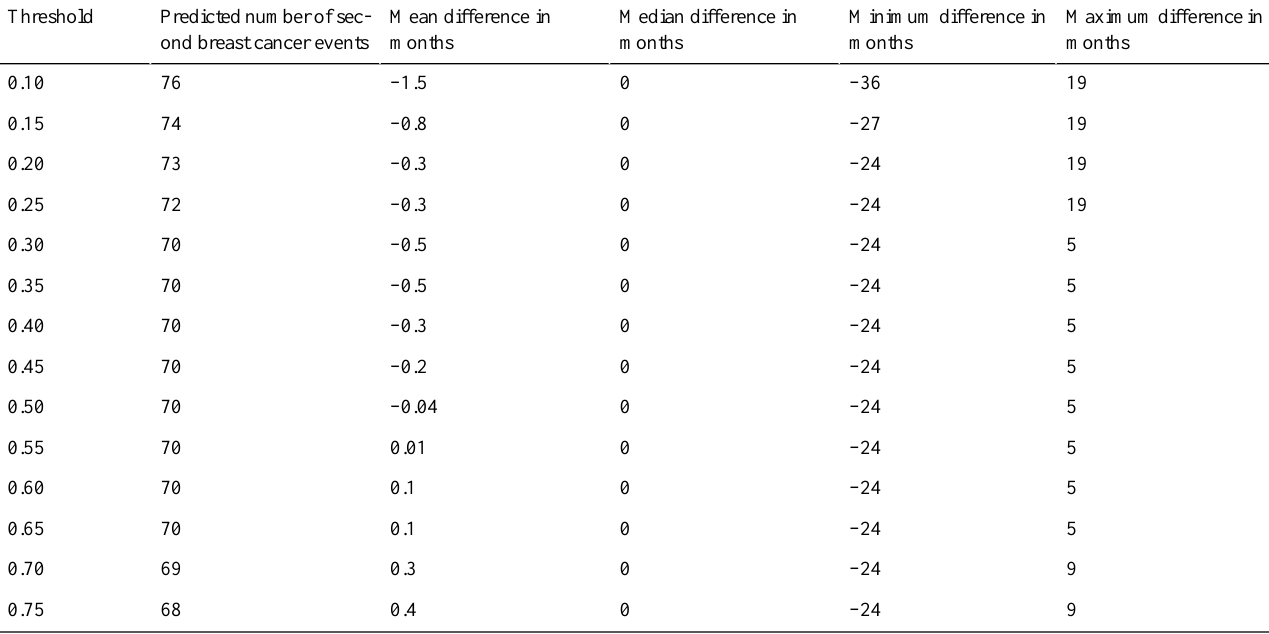
Table 3. Accuracy of the predicted timing of a second breast cancer event at each of a set of threshold probabilities a .